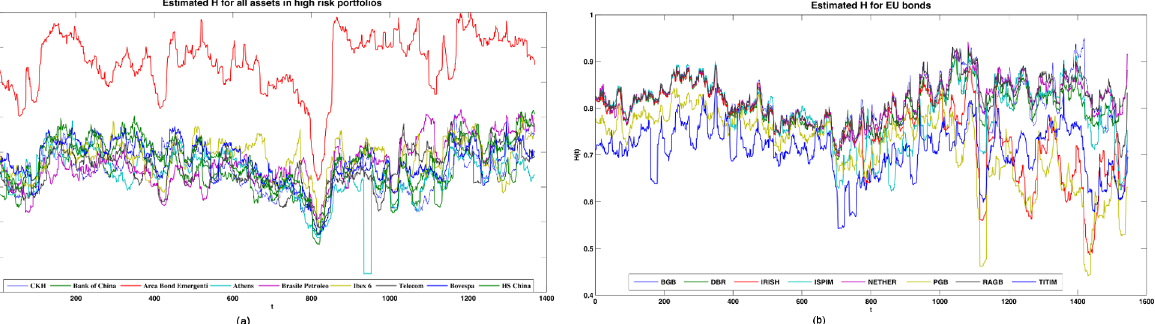
Fig 2. H of the assets. (a) H of the high risk assets: the indexes, shares and the Arca Bond Emergenti portfolio. (b) H of the low risk assets: the EU area